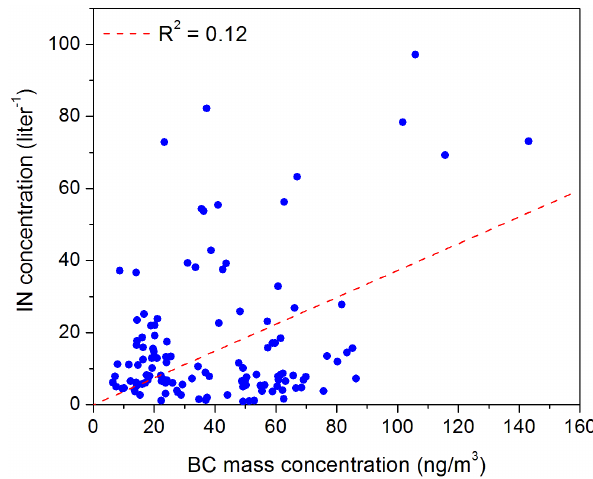
Fig. 12. IN number concentration versus BC concentration during both campaigns on clear